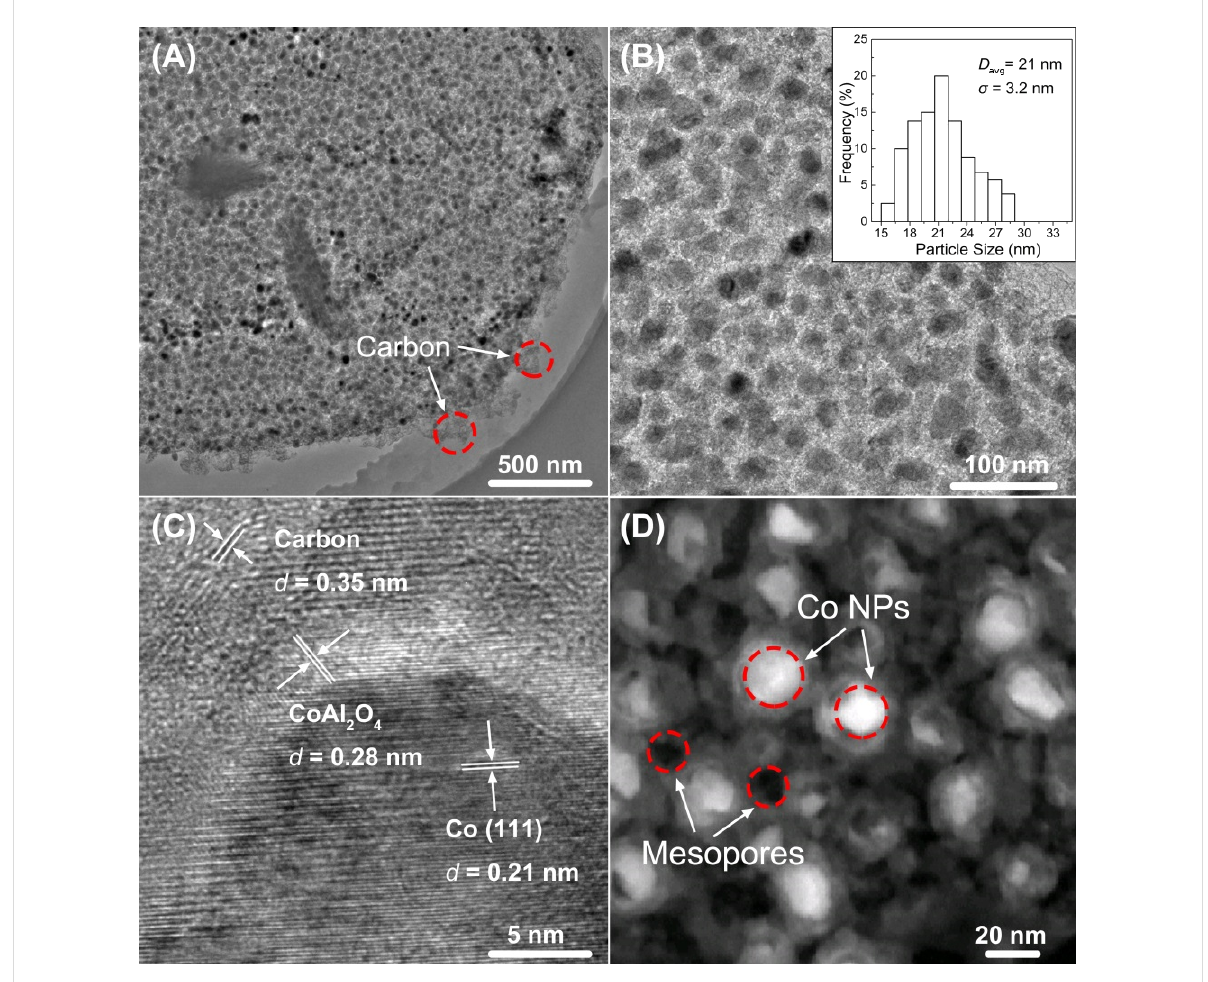
Figure 3: (A–C) TEM images of the hexagonal mesoporous sample NPLs-2.5-800, the inset in (B) shows the corresponding size histogram obtained by statistical analysis of over 80 Co nanoparticles. (D) HAADF-STEM image of the hexagonal mesoporous sample NPLs-2.5-800.